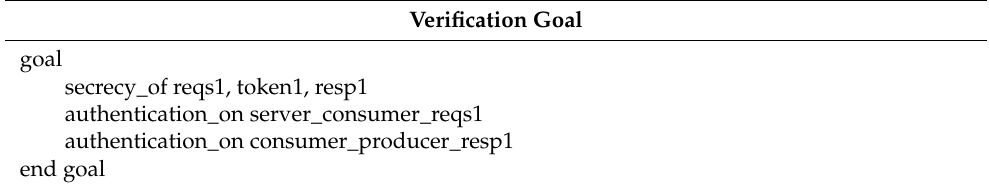
Table 8. Verification objectives of formal analysis.